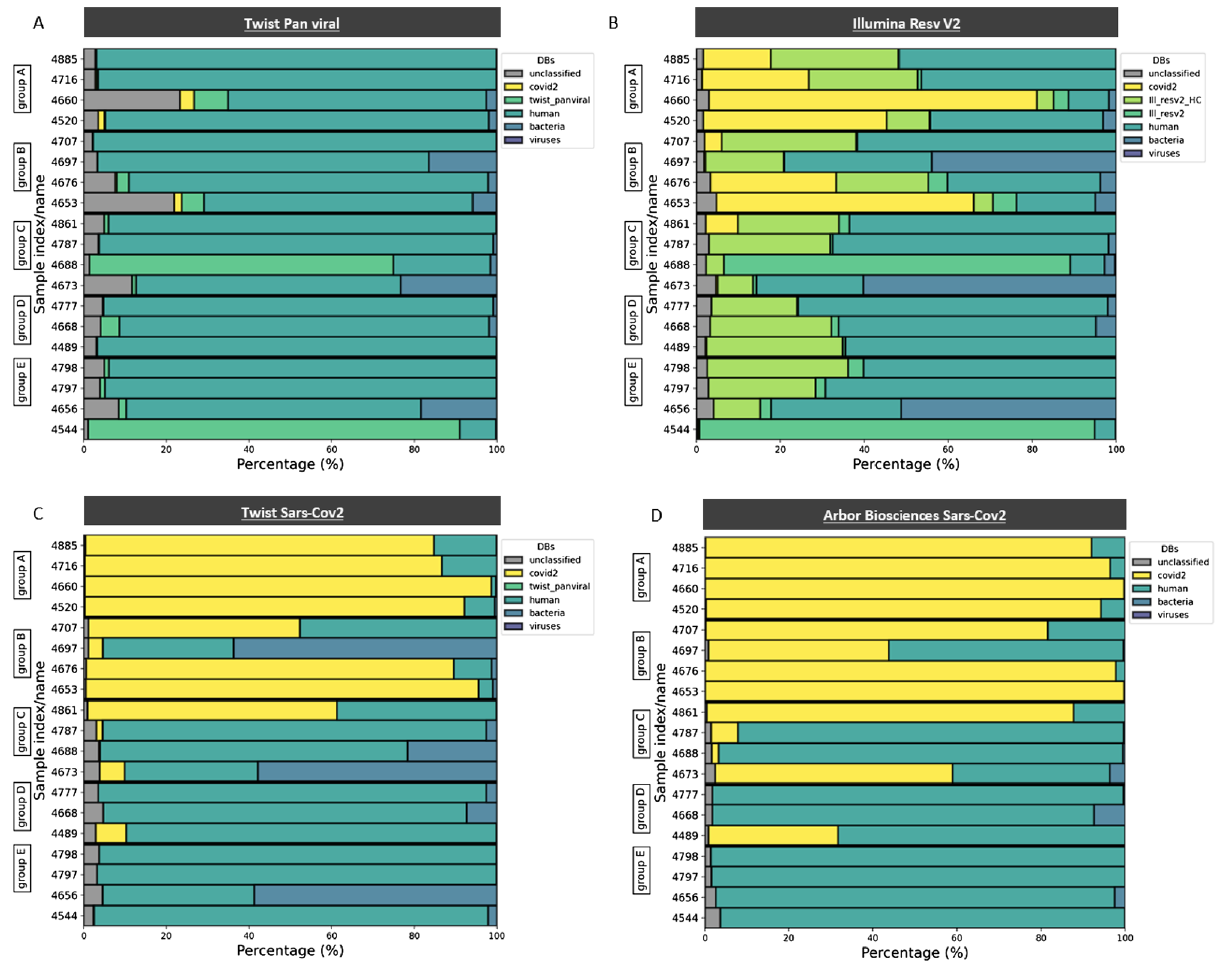
Figure 5. Taxonomic analysis of all panels tested using Kraken2. All reads captured using the four different panels were compared to human, virus, SARS-CoV-2, and bacterial databases. ( A ) For the Twist Pan-Viral capture panel, a supplementary database containing the genome of all viruses from the panel was used. ( B ) For the Illumina Resv V2 panel, two supplementary databases containing the human control genome and the genome of all viruses from the panel were used. ( C ) The Twist SARS-CoV-2 and ( D ) Arbor Biosciences SARS- CoV-2 panels did not require supplementary databases for this analysis. For all panels, all reads not matching any of the databases used were identified as